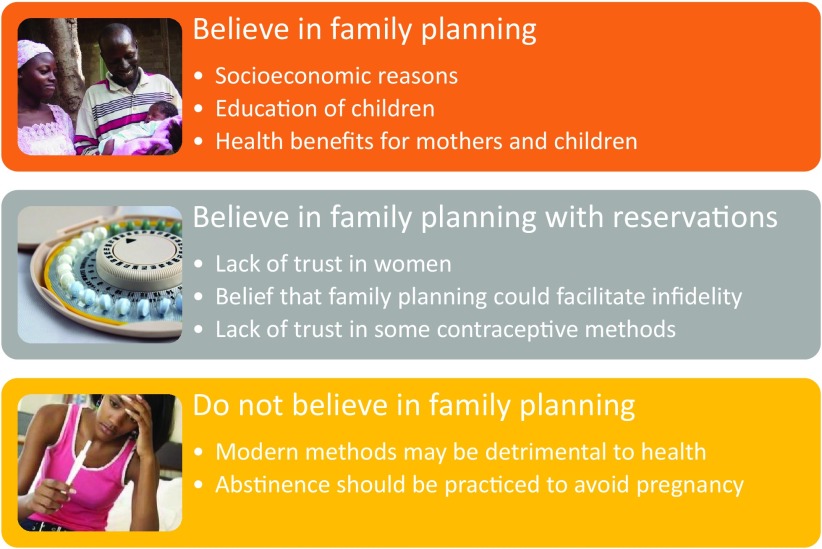
Three Categories of Male Focus Group Participants Based on General Views of Family Planning, Lomé, Togo, 2016